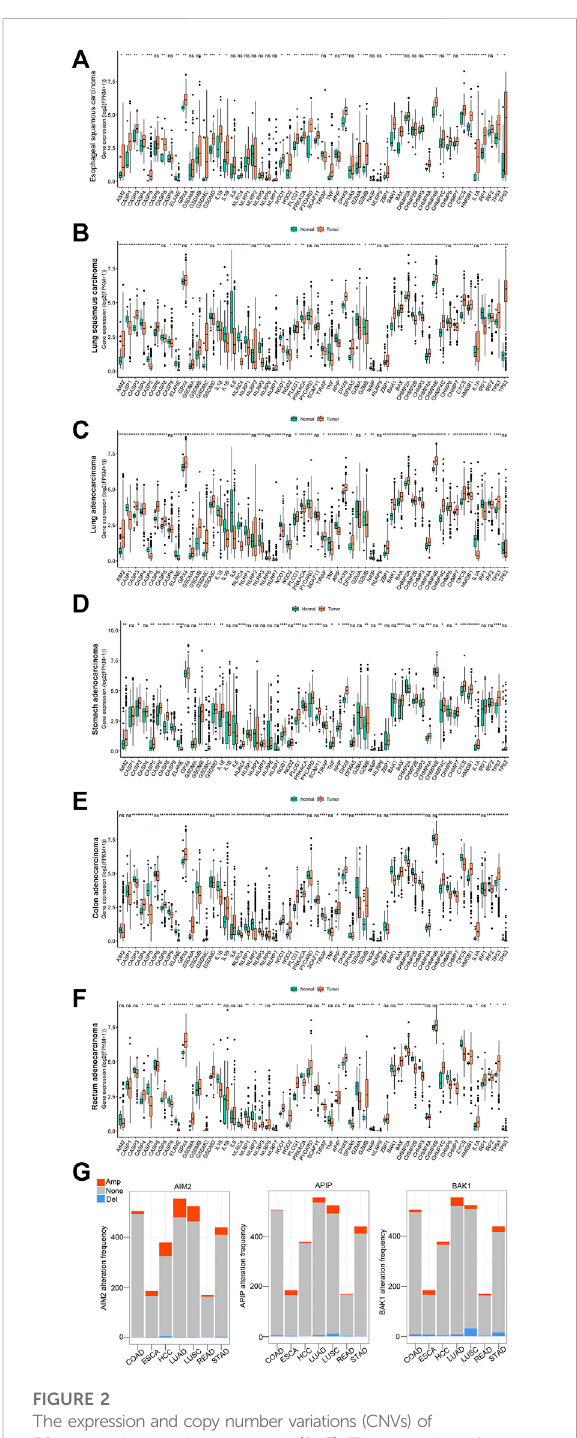
FIGURE 2 The expression and copy number variations (CNVs) of 56 pyroptosis genes in pan-cancer. (A – F) : The expression of 56 pyroptosis genes in esophageal squamous carcinoma (ESCA), lung squamous carcinoma (LUSC), lung adenocarcinoma (LUAD), stomach adenocarcinoma (STAD), colon adenocarcinoma (COAD) and rectum adenocarcinoma (READ). *Indicates p < 0.05, ** indicates p < 0.01, ***indicates p < 0.001 (the same below). (G) : The copy number variations of AIM2, APIP, and BAK1 in pan-cancer. The orange color indicates ampli fi cation (Amp). The blue color indicates deletion (Del). The grey color indicates no copy number variations